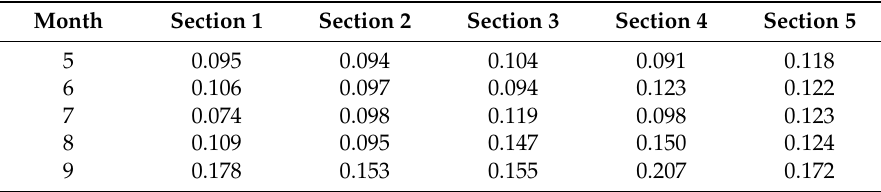
Table 10. Collapse rates of study sections in different months (Unit: m/d).